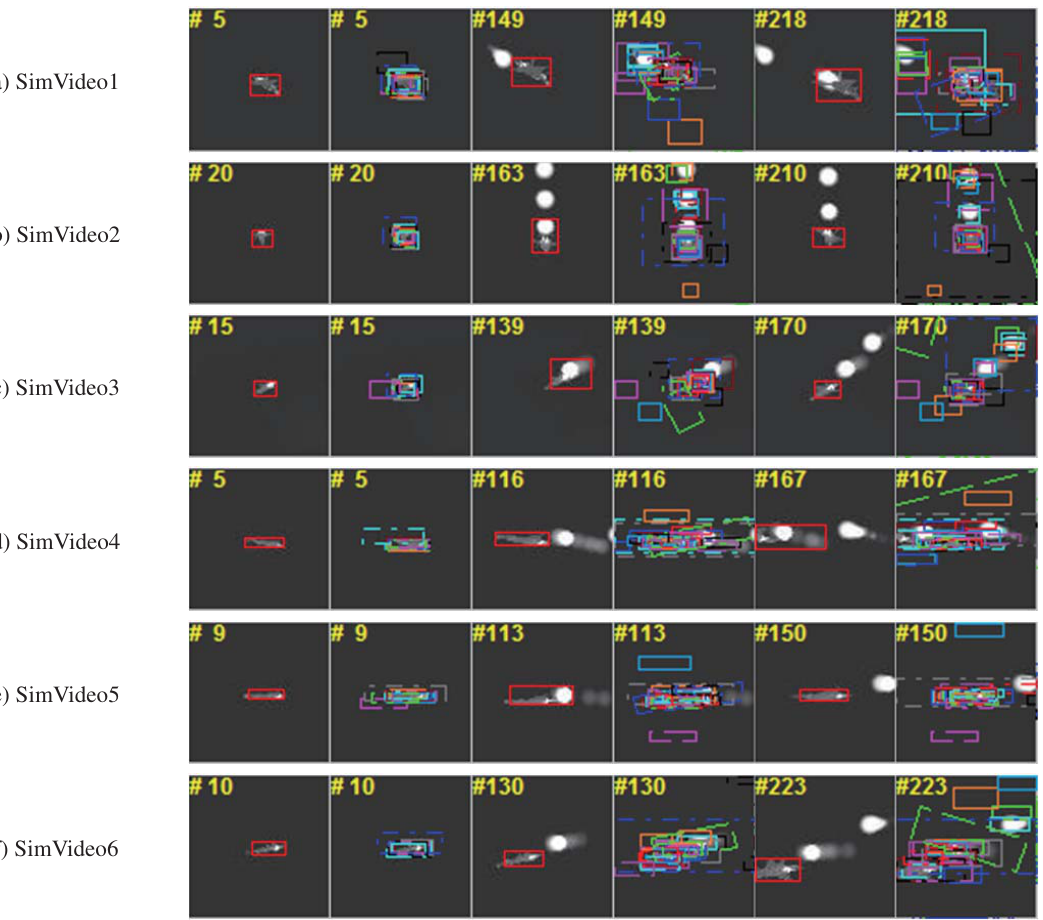
Figure 19. Tracking results of simulated infrared sequences. Our tracker’s results are drawn with a red rectangle for